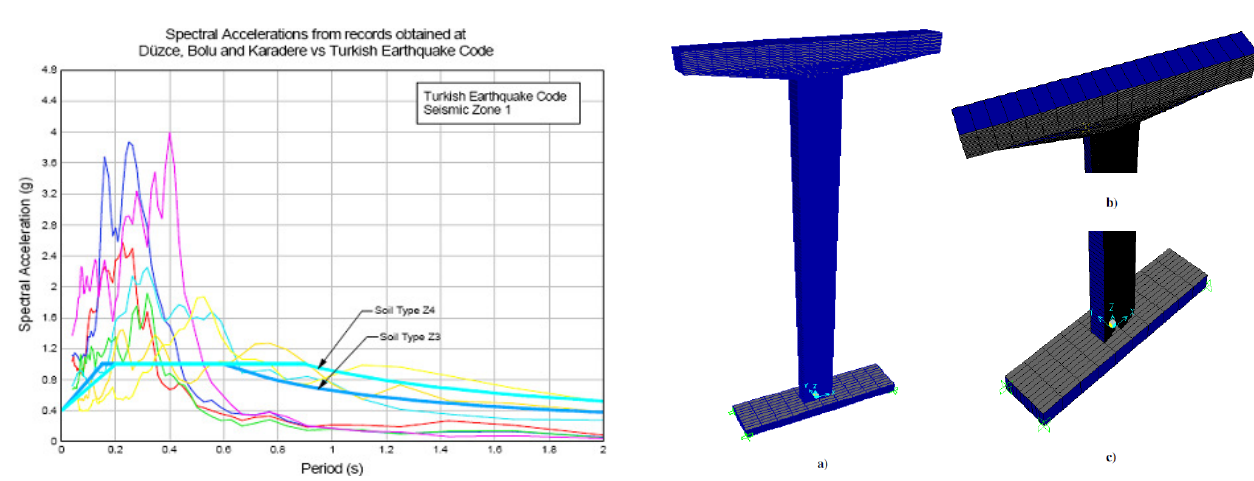
Figure 8: The comparison of spectrum between Turkish Earthquake Code and site data